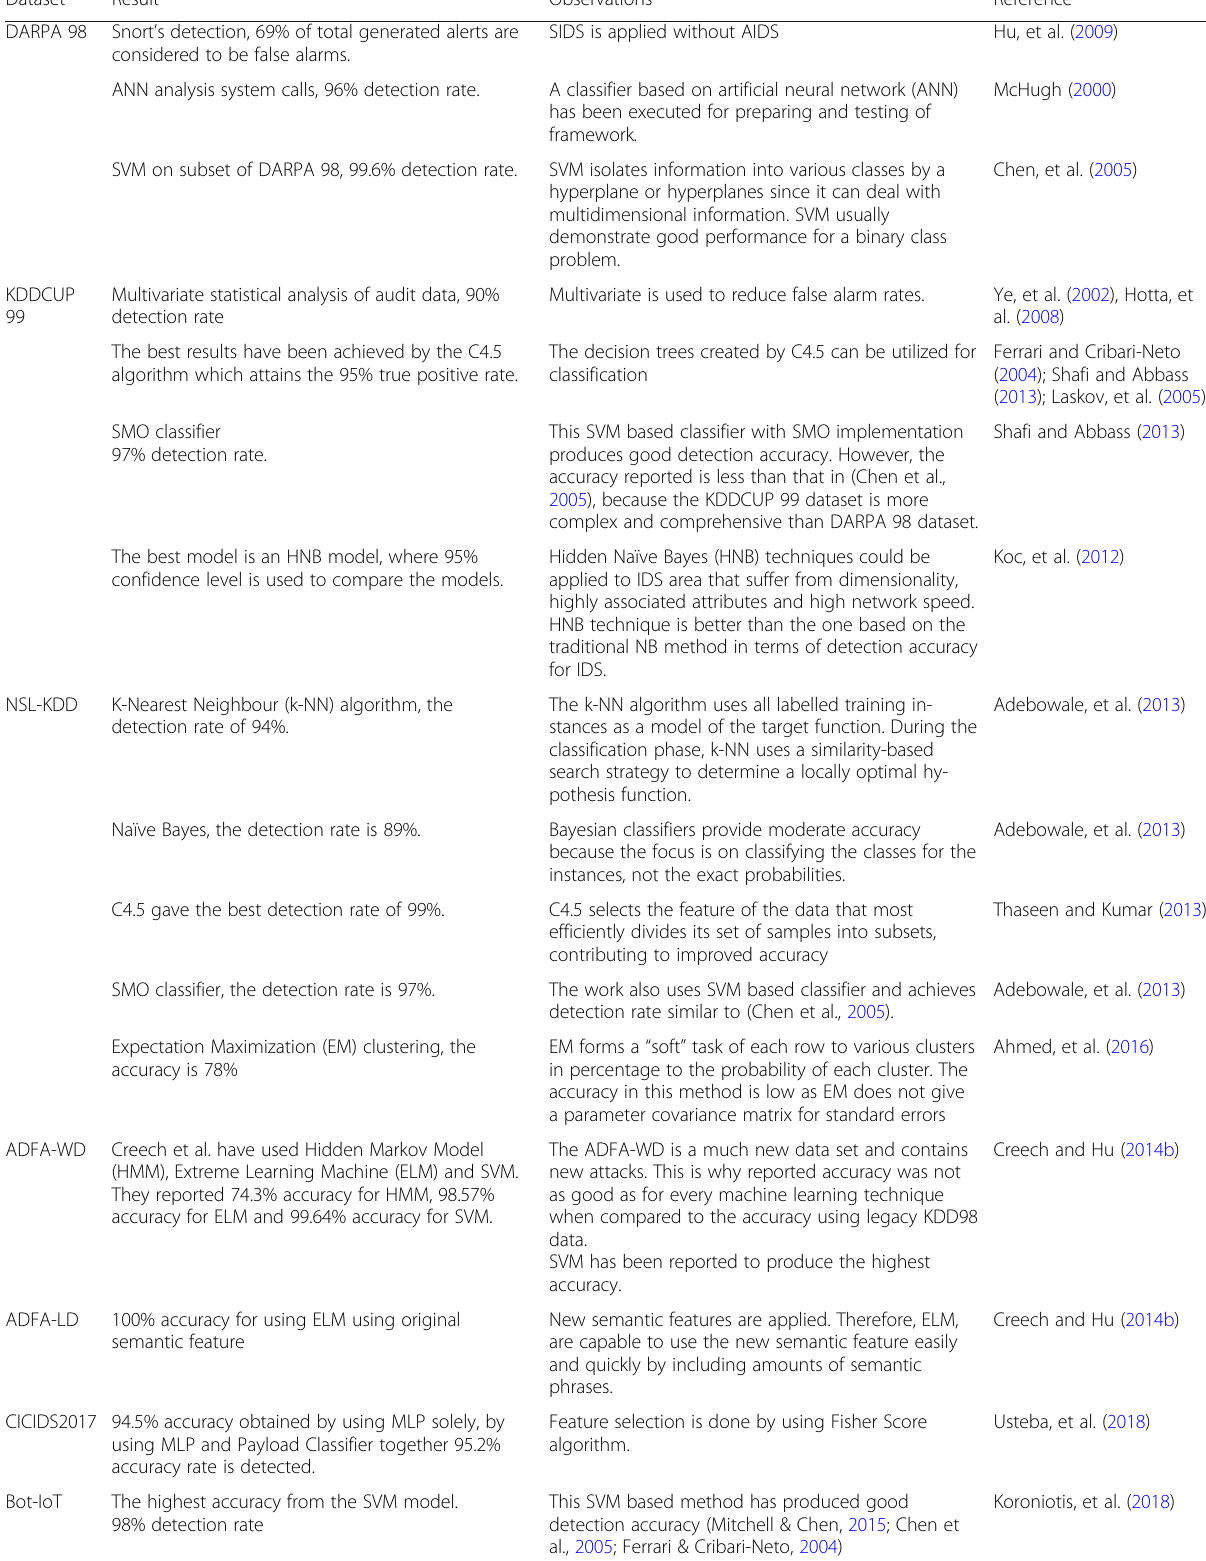
Table 12 Comparison of results achieved by various methods on publically available IDS datasets Dataset Result